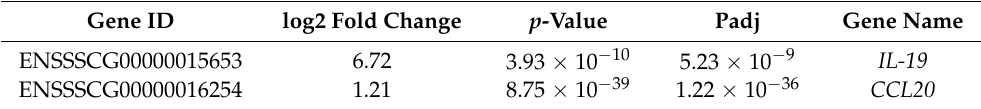
Table 1. Transcription analysis results of IL-19 and CCL20 (PEDV vs. CON). Gene